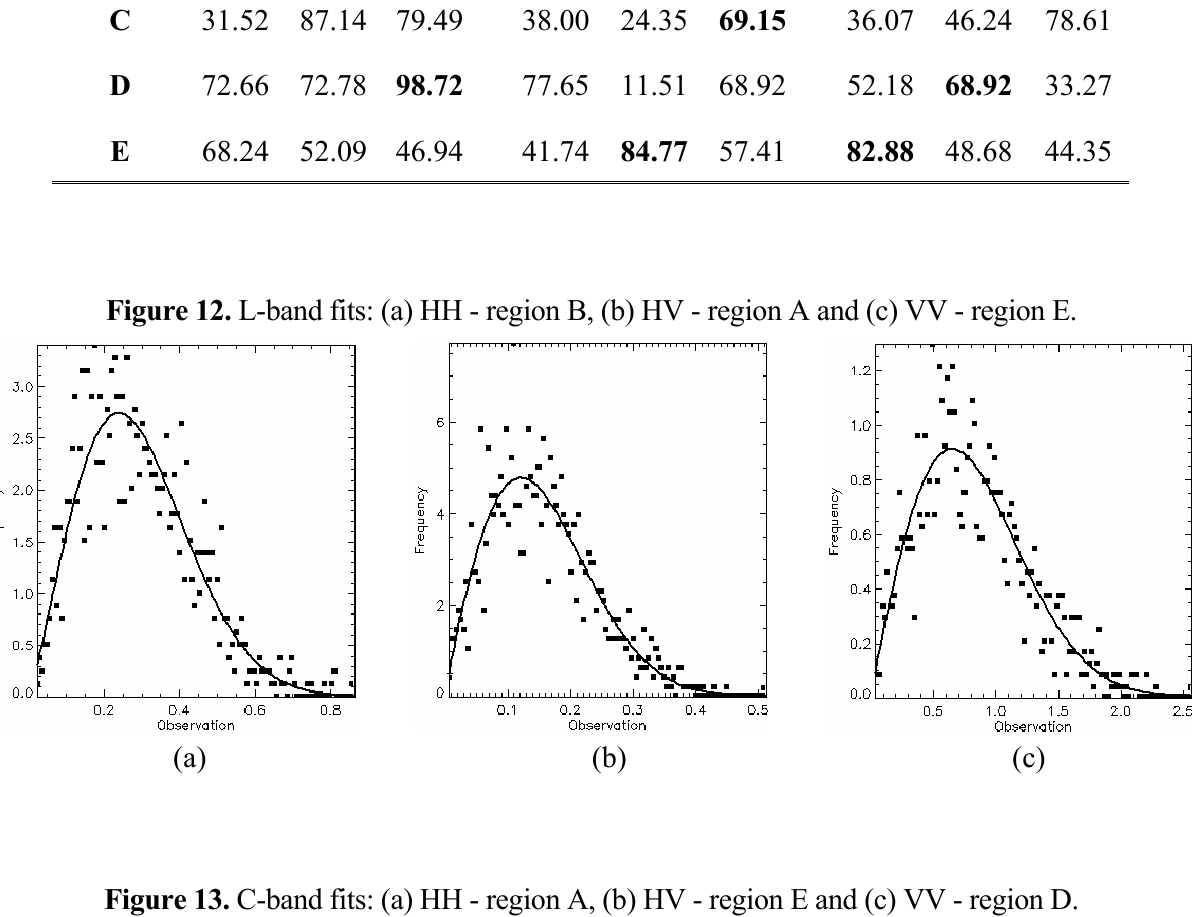
Figure 13. C-band fits: (a) HH - region A, (b) HV - region E and (c) VV - region